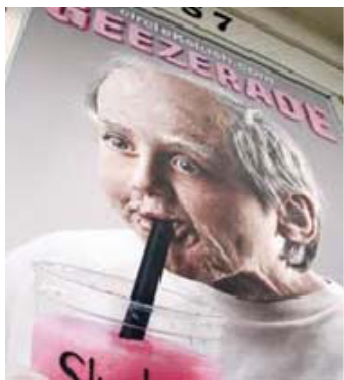
Geezerade Advertisement. The Weekly News, Summer 2011. Figure 8. Geezerade Online Advertisement Summer 2011.